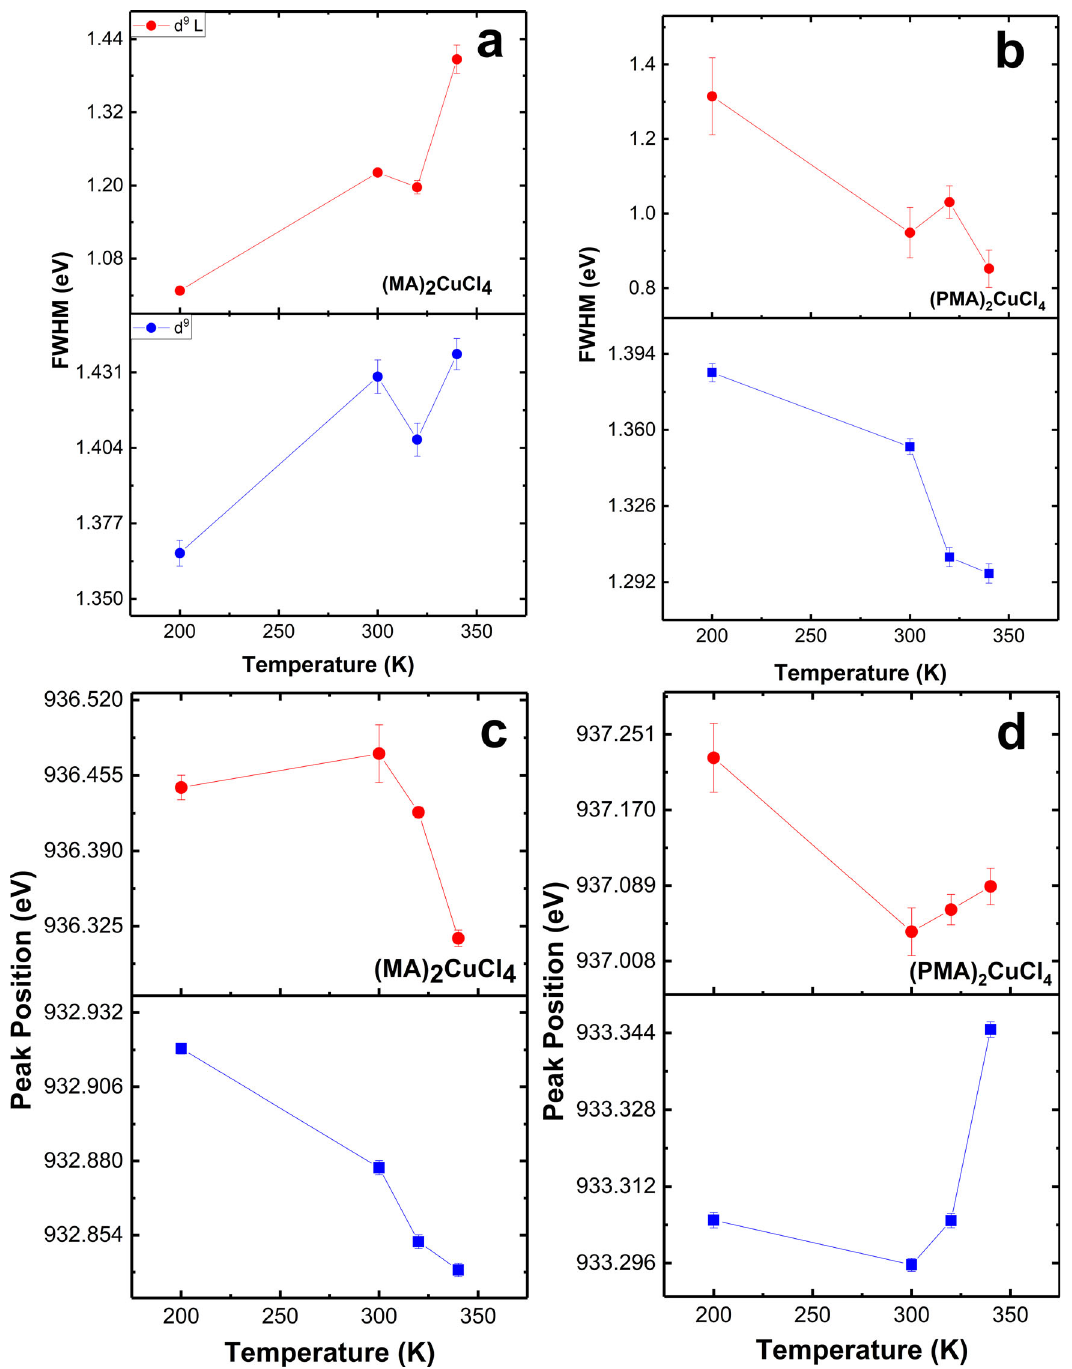
Fig. 2 FWHMs and peak positions extracted from XAS spectra, demonstrating the implication of short versus long ligand size on their linewidth spectral analyses. The FWHM pro fi le corresponds to the d 9 L (red circles) and d 9 (blue squares) of (MA) 2 CuCl 4 ( a ) and (PMA) 2 CuCl 4 ( b ), respectively. The peak position variation corresponds to the d 9 L (top) and d 9 (bottom) of (MA) 2 CuCl 4 ( c ) and (PMA) 2 CuCl 4 ( d ), respectively. Error bars are collected from the respective fi tting